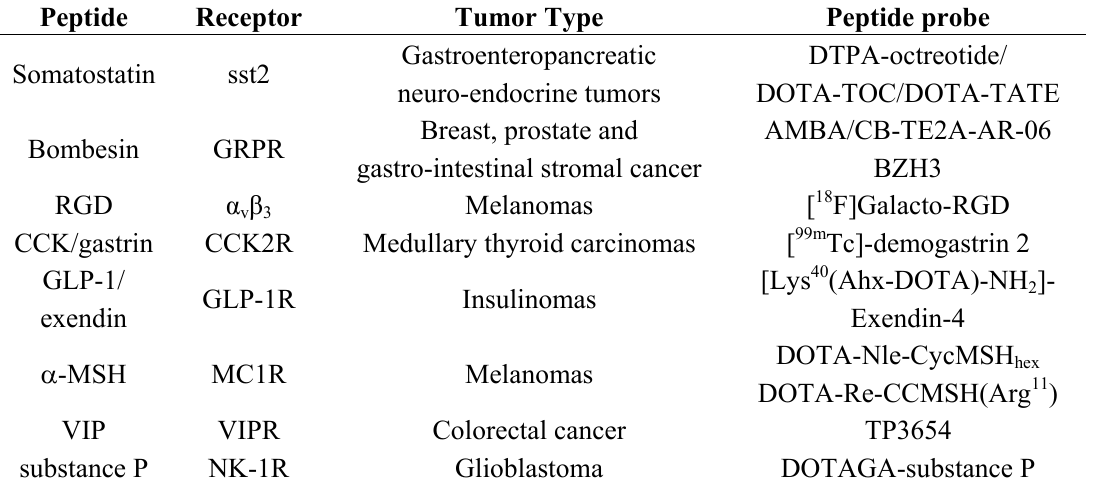
Table 2. Peptide receptors, disease indications and peptide probe in clinical